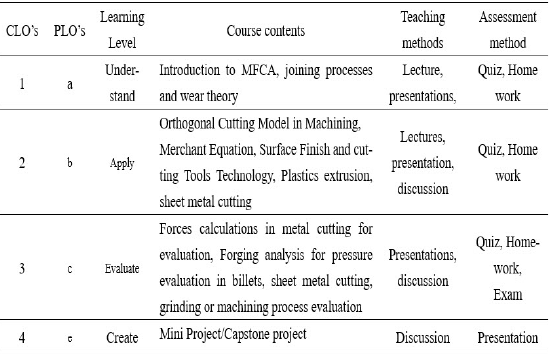
Table 4. Curriculum